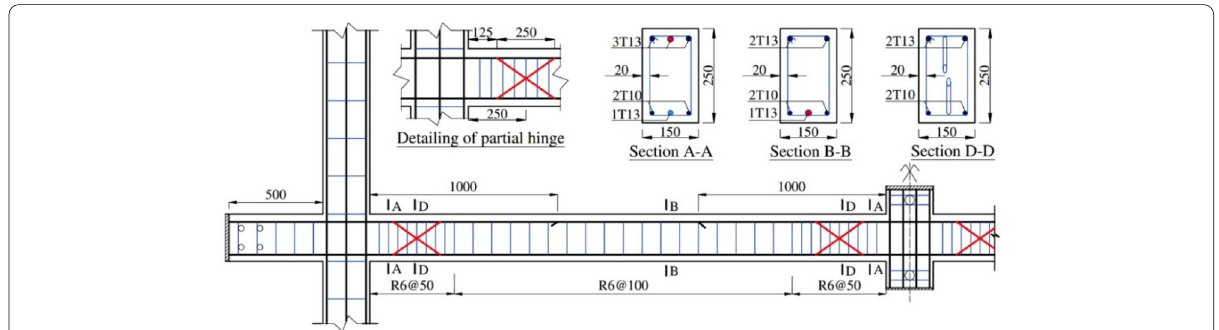
Fig. 5 The specimen detailed by partial hinges. Image by courtesy of Yu (Nanyang Technological